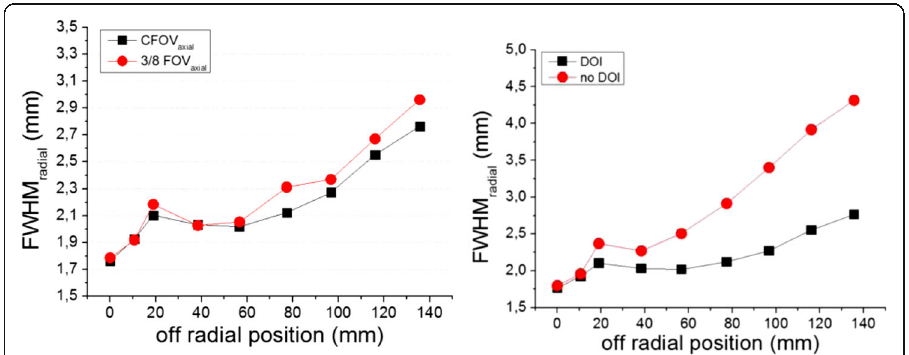
Fig. 9 Left, radial FWHM (3 iterations and DOI correction) of the source PSF as a function of the radial position at the axial center and 3/8 (17.25 mm). Right, radial FWHM (3 iterations) as a function of the radial position at the axial center, but with (black squares) and without (red circles) DOI